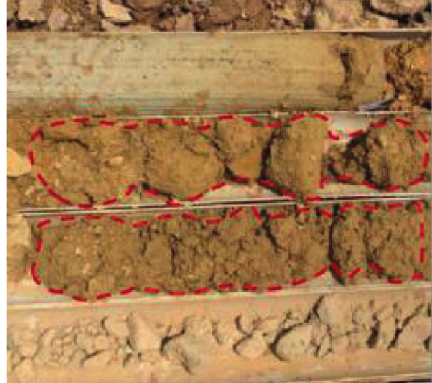
Figure 2: Core drilling characteristics of sand